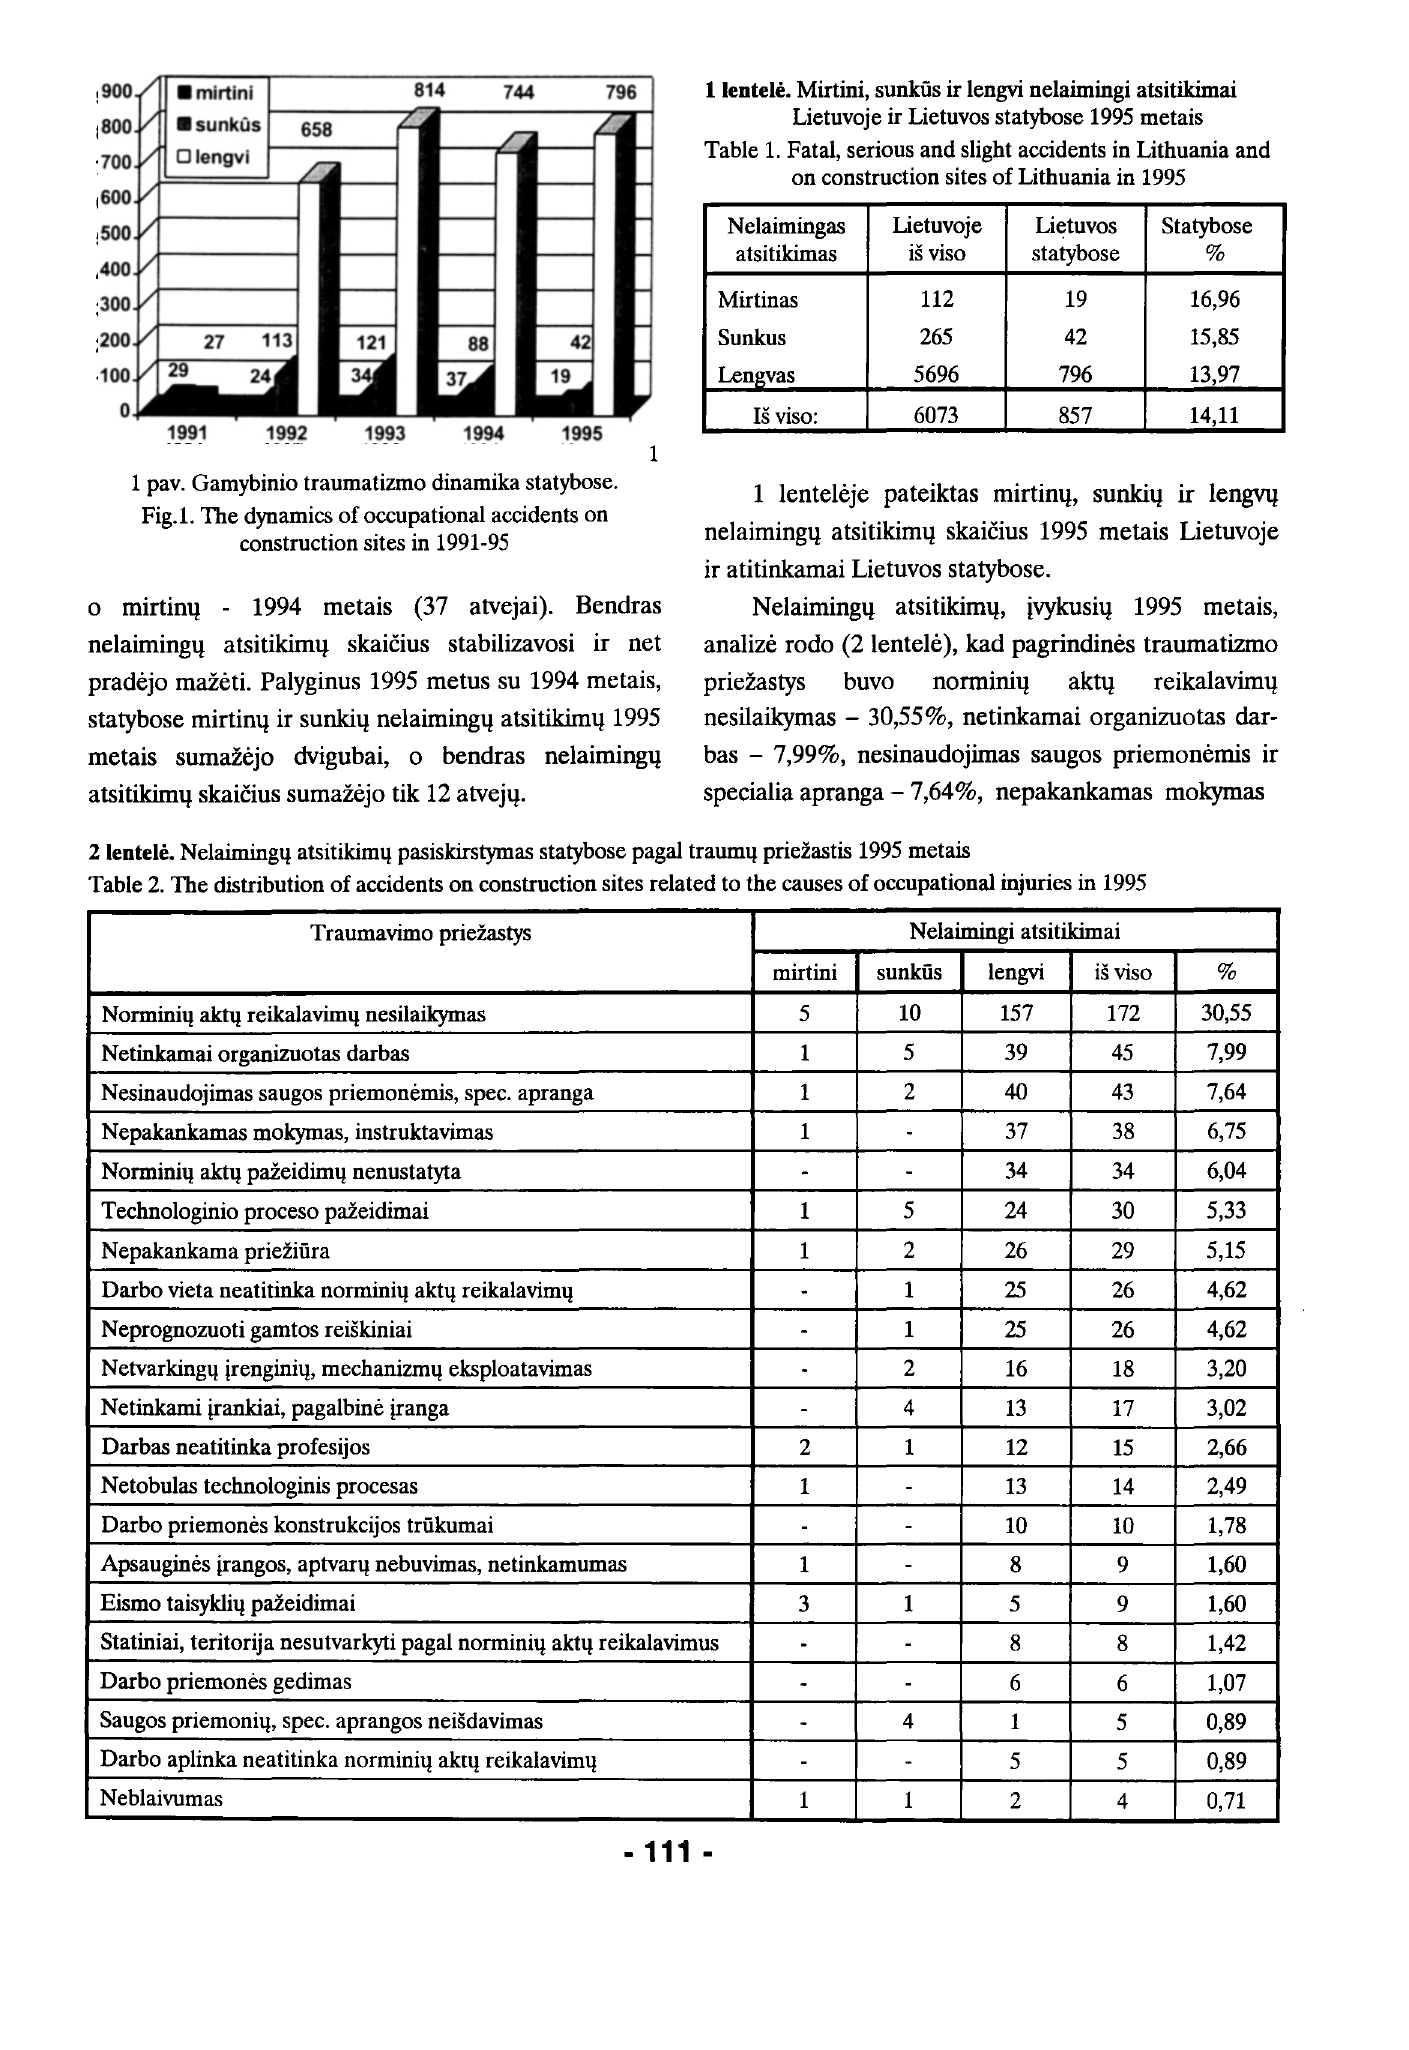
Table 1. Fatal, serious and slight accidents in Lithuania and on construction sites of Lithuania in 1995